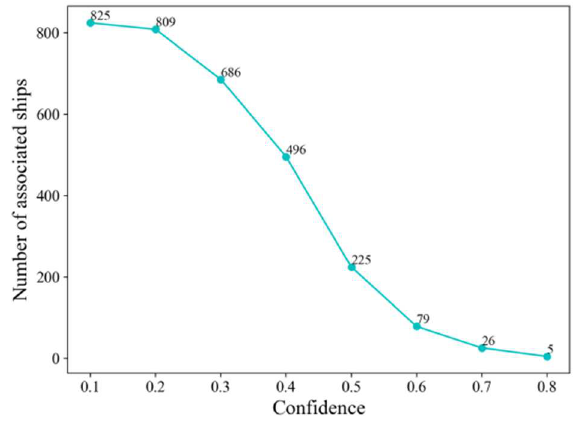
Figure 6. Degree of the confidence impact analysis.